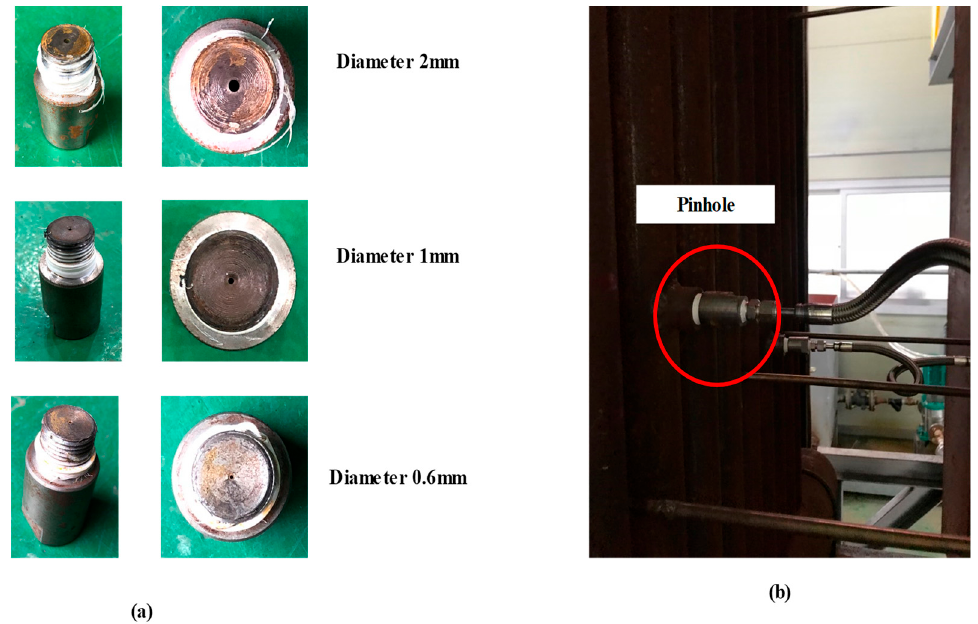
Figure 6. ( a ) Pinholes of different sizes used in the experiments; ( b ) a typical installation of a pinhole on the boiler tube.